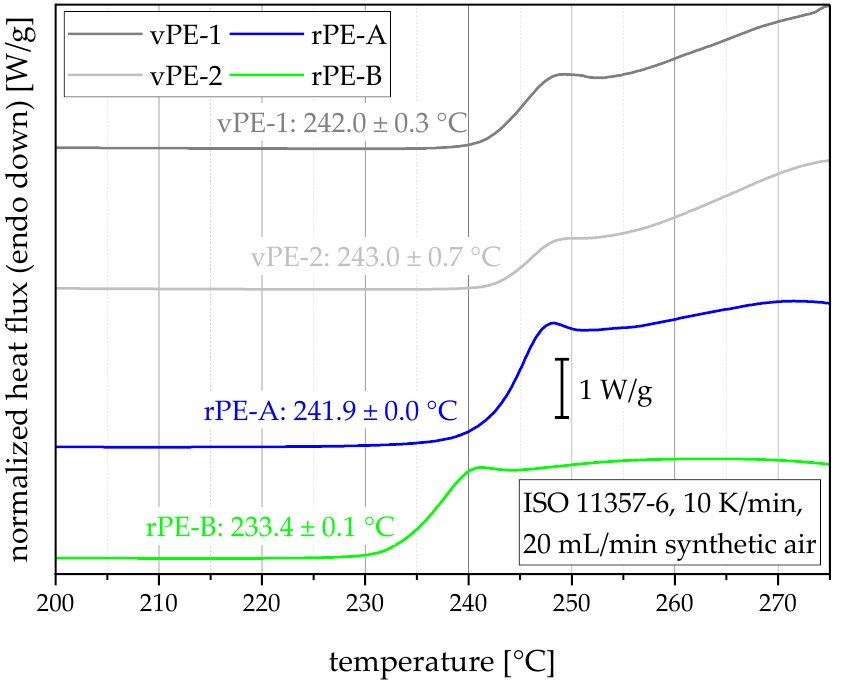
Figure 7. Averaged DSC thermograms (two or three measurements for one curve) and values of oxidation induction temperatures for all materials. Curves are stacked for better visibility.